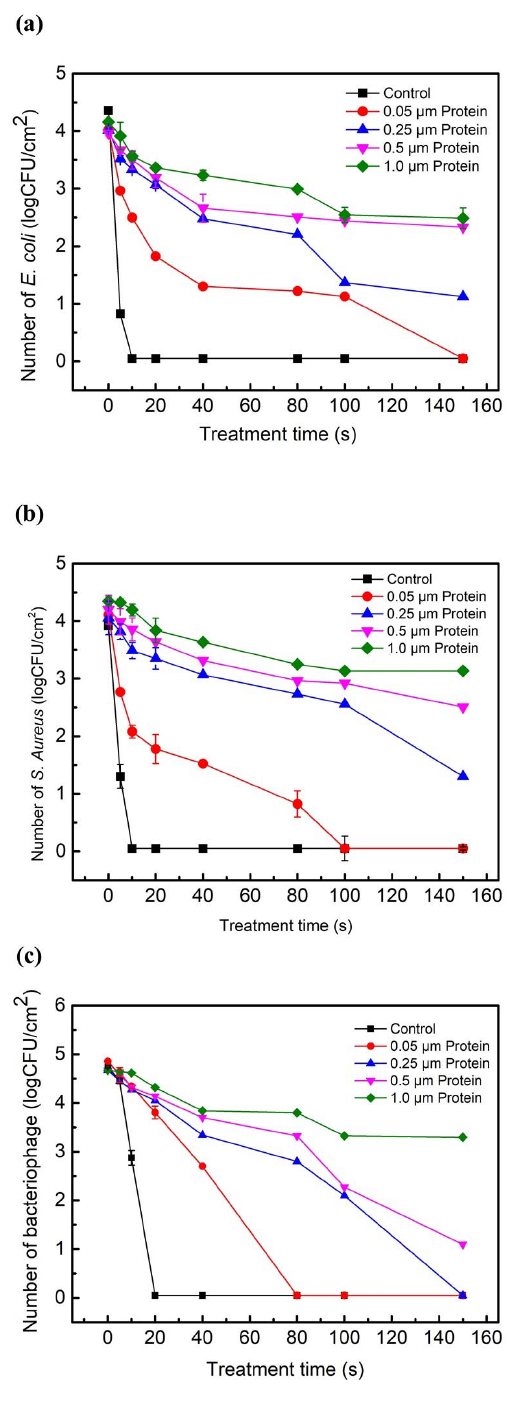
Figure 2. The number of surviving E. coli ( a ), S. aureus ( b ), and bacteriophages ( c ) in the protein biofilms as a function of the plasma treatment time. The plasma inactivation was performed at V PP = 8.25 kV and a power of 460 W; 10 μ L of the aqueous solutions containing microbes and proteins was spread onto each steel disc (1.0 cm 2 ) and placed for 10 min under air flow in a biosafety cabinet to allow drying. The thickness of the protein biofilms varied from 0.05 μ m to 1.0 μ m. The steel discs with dry biofilms were placed into the humidified air DBD chamber for plasma inactivation. The control samples were not covered with protein films. The samples with the treatment time of 0 s were the untreated control. Means ± standard deviations of experiments carried out at least in trip ‐ licate are shown.